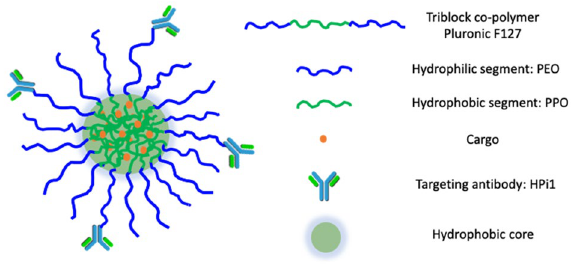
Figure 1. Schematic structure of cell type selective cargo encapsulating nanocarriers in aqueous solution. PEO polyethylene oxide, PPO polypropylene